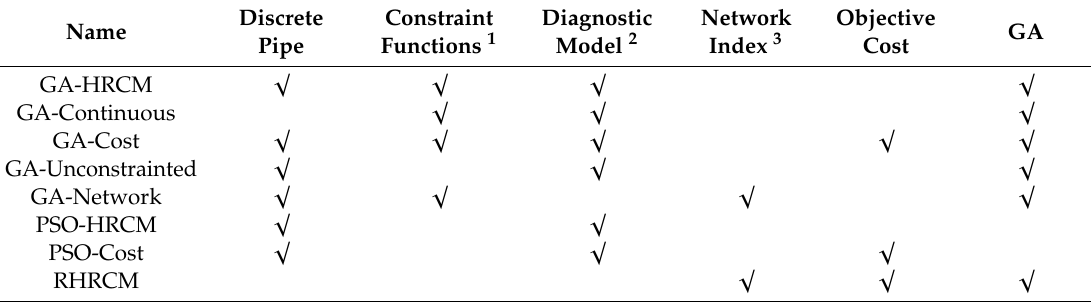
Table 2. Parameter setting of di ff erent HRCM